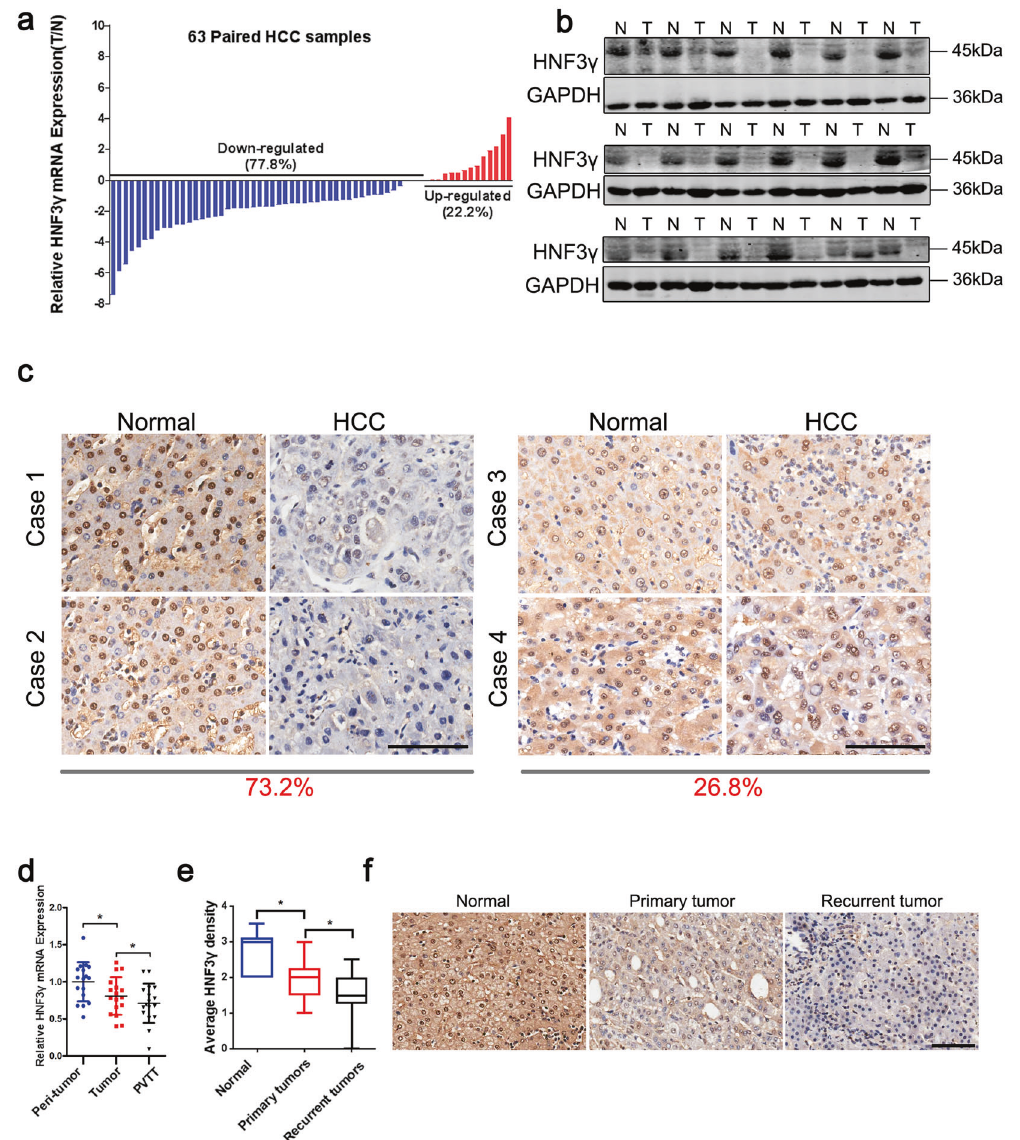
Fig. 1 Suppressed HNF3 γ expression in patient HCC tissues. a mRNA expression of HNF3 γ in 63 pairs of HCC (T) and peri-tumoral normal (N) tissues was determined by real-time PCR. The majority of patients (77.8%) exhibited reduced HNF3 γ expression in HCC tissues. b Western blotting assay of HNF3 γ expression in 18 peri-tumoral normal (N) and paired HCC (T) tissues. c Representative views of HNF3 γ expression in 156 paired HCC and peri-tumoral normal tissues from Cohort 1 after IHC staining. The majority of patients (73.2%) exhibited decreased HNF3 γ expression in HCC tissues. Scale bar, 100 μ m. d HNF3 γ expression was compared between 17 paired normal peri-tumoral, primary HCC, and PVTT tissues by real-time PCR (* p < 0.05). e , f HNF3 γ levels were compared between 21 pairs of peri-tumoral normal, primary HCC, and recurrent tumor tissues by IHC staining. Representative images are shown. Scale bar, 100 μ